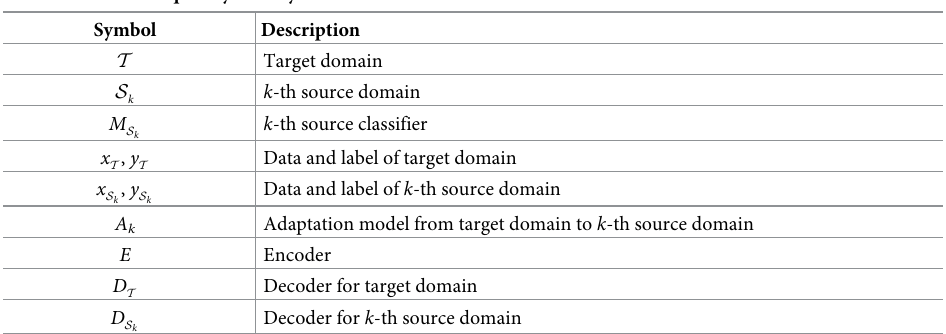
Table 2. Table of frequently-used